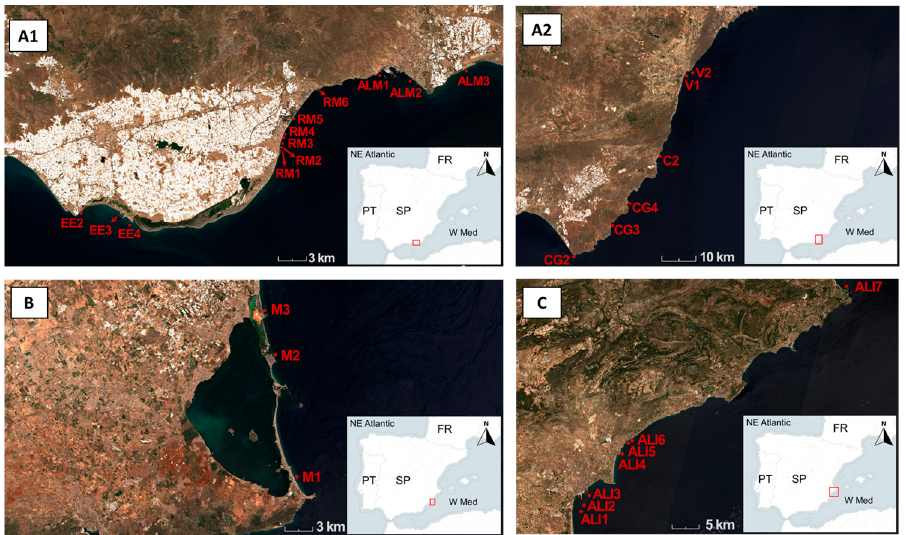
Figure 1. Maps of the surveyed points on the Mediterranean Spanish coast: ( A1 ) Western Almeria, ( A2 ) Eastern Almeria, ( B ) Murcia and ( C ) Alicante stations. White areas seen on land correspond to greenhouses. Figure made by the authors using Copernicus Sentinel data (2022) and processed with EO Browser.